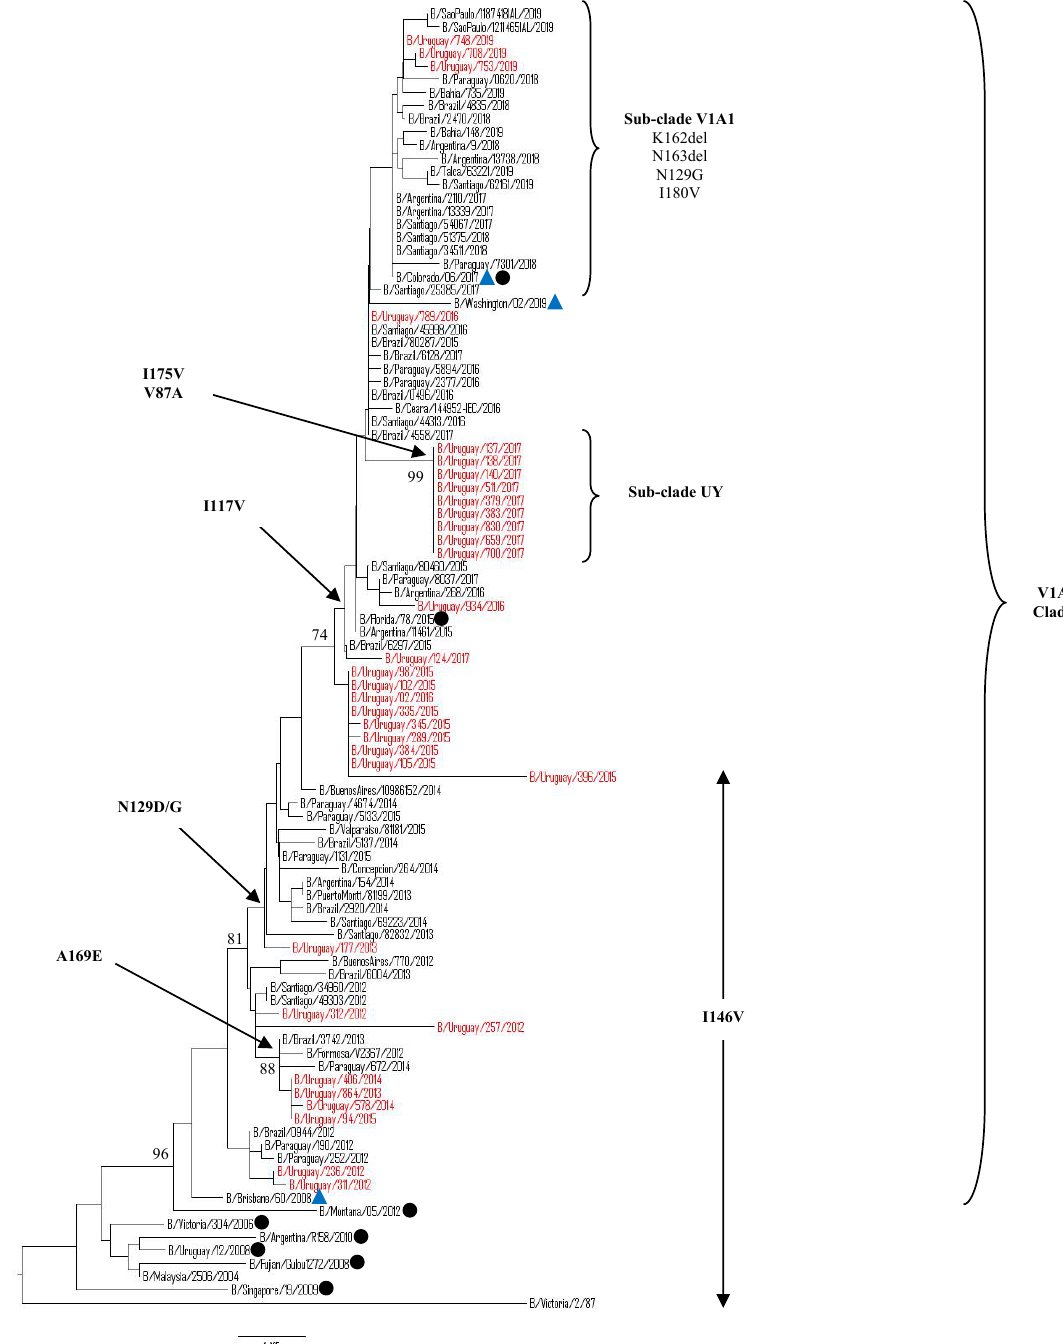
Figure 4. Phylogenetic analysis of the HA1 nucleotide sequences from influenza B Victoria-lineage viruses circulating in Uruguay from 2012 to 2019. The phylogeny tree was generated by the neighbor-joining method with 1000 bootstrap replicates. Bootstrap values >70 are shown in the nodes. Vaccine strains are preceded by blue triangles. Uruguayan strains are shown in red while representative clade strains are indicated with a black circle as a symbol. The scale bar indicates nucleotide substitutions per site. The most relevant amino acid substitutions found are indicated with arrows.